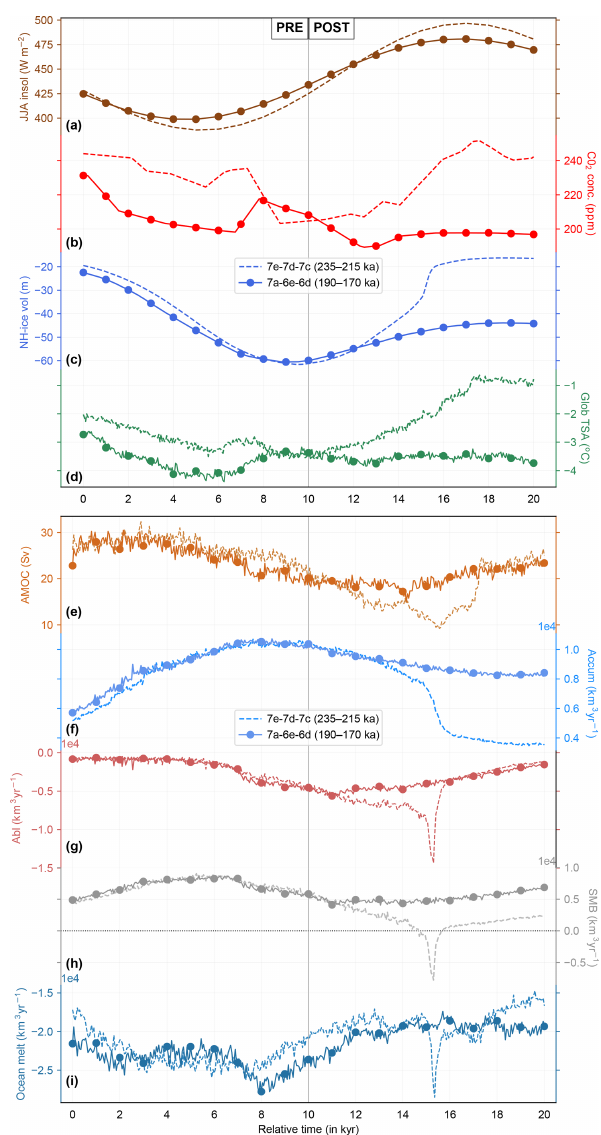
Figure 6. Comparison between two glacial inception scenarios. Different variables over two 20kyr periods (relative time) during pre-inception (left half) and post inception (right half) over the Northern Hemisphere are plotted. Variables from the earlier period (235–215ka) are plotted in dashed lines, while that of the later pe- riod (190–170ka) are plotted in circled solid lines. (a) JJA mean insolation at 65 ◦ N (Wm − 2 ; Laskar et al., 2004). (b) CO 2 con- centration (ppm; Lüthi et al., 2008). (c) Simulated Northern Hemi- sphere ice volume, in sea level equivalents (m). (d) Global aver- age surface temperature anomaly ( ◦ C). (e) Temporal evolution of AMOC (Sv). (f) Net integrated accumulation rate over Northern Hemisphere ice (km 3 yr − 1 ). (g) Net integrated surface melt rate over Northern Hemisphere ice (km 3 yr − 1 ). (h) Net integrated sur- face mass balance over the Northern Hemisphere ice (km 3 yr − 1 ). (i) Net integrated subshelf melt rate over Northern Hemisphere (km 3 yr − 1